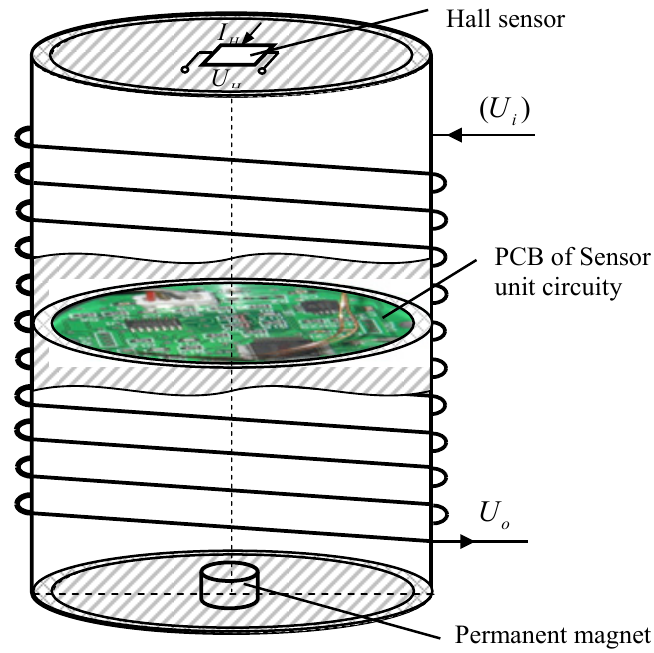
Figure 1. Structural diagram of a II-type deep displacement sensor